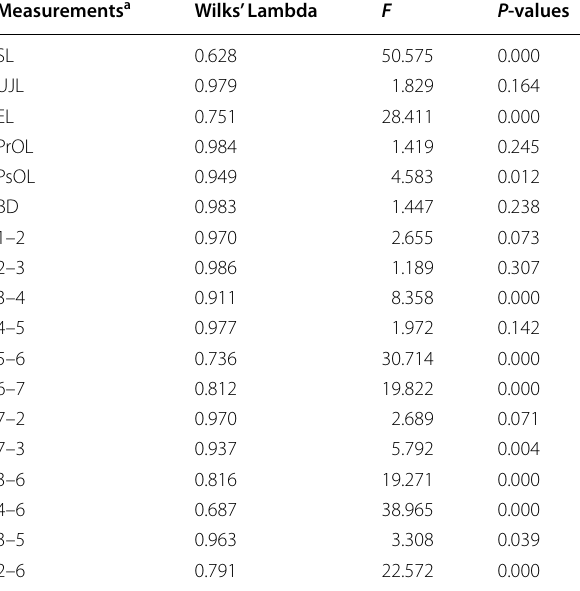
Table 4 Univariate statistics of conventional morphometric